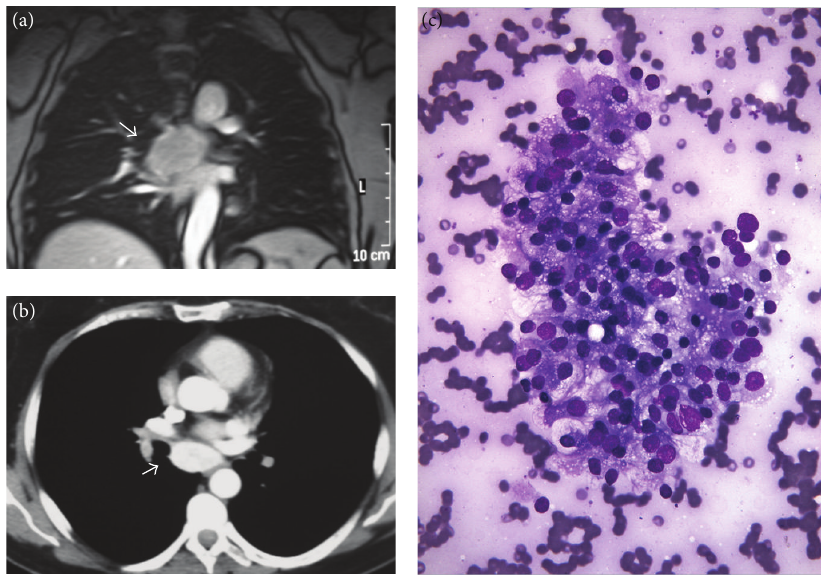
Figure 1: Metastatic renal cell carcinoma. (a and b) Computed tomography showed the renal metastatic mass (arrow) in the mediastinum. (c) Fine-needle aspiration biopsy guided by endoscopic ultrasonography of the mediastinal tumor revealed clusters of epithelial malignant cells morphologically fitting with metastatic clear cell renal cell carcinoma